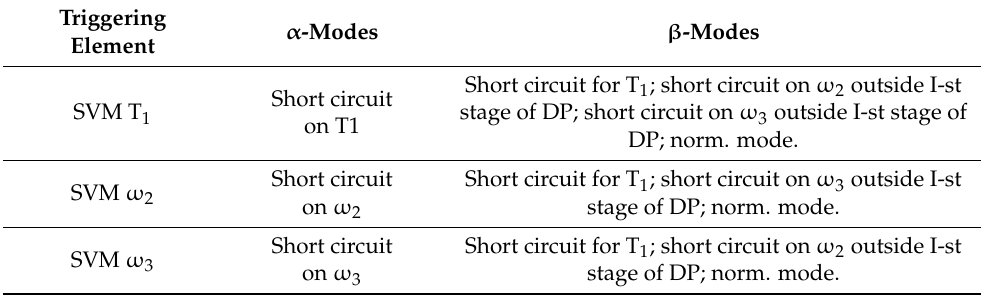
Table 3. Formation of sets of α - and β -modes for developing triggering